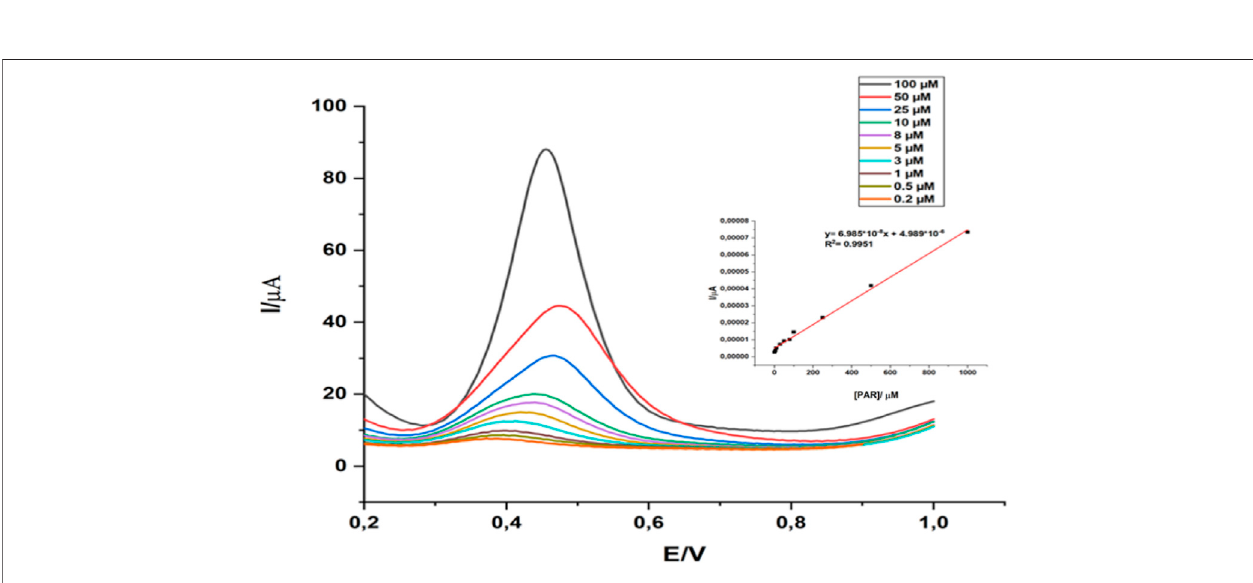
Frontiers in Sensors |